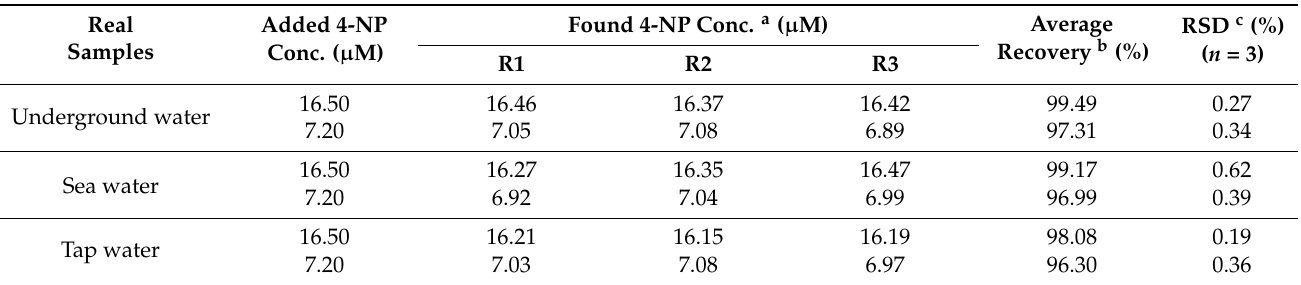
Table 2. Validity analysis of environmental real-samples with Pt-NPs-embedded PPy-CB@ZnO NCs/PEDOT:PSS/GCE sensor probe, using an electrochemical